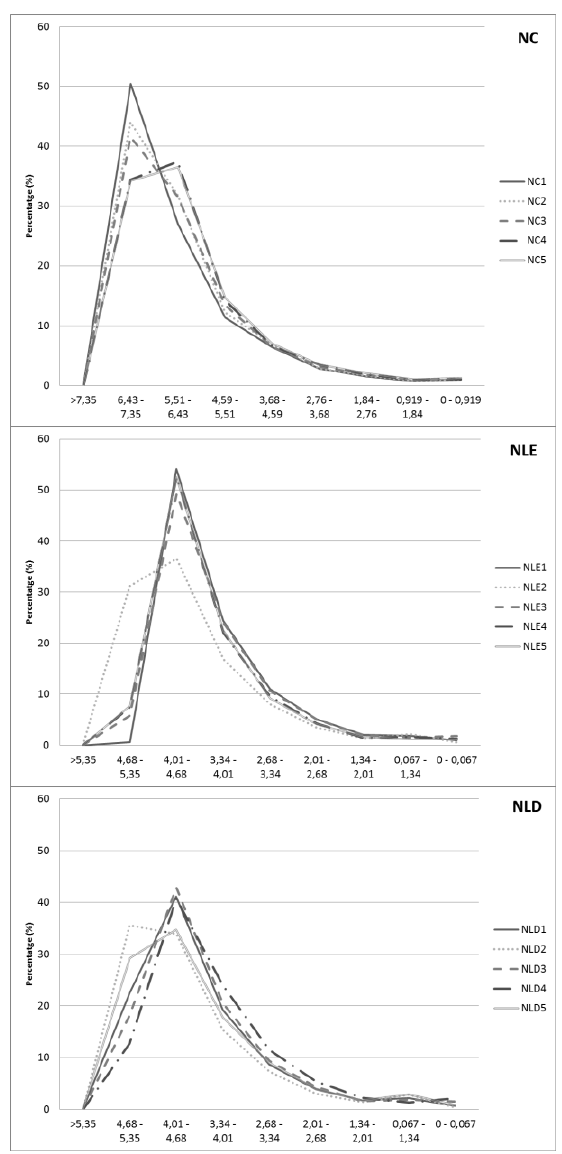
Figure 7. Ranges of distances between vaults and comparison plane (PC): a) Central Nave (NC), b) Lateral Nave, Gospel Side (NLE), c) Lateral Nave, Epistle Side